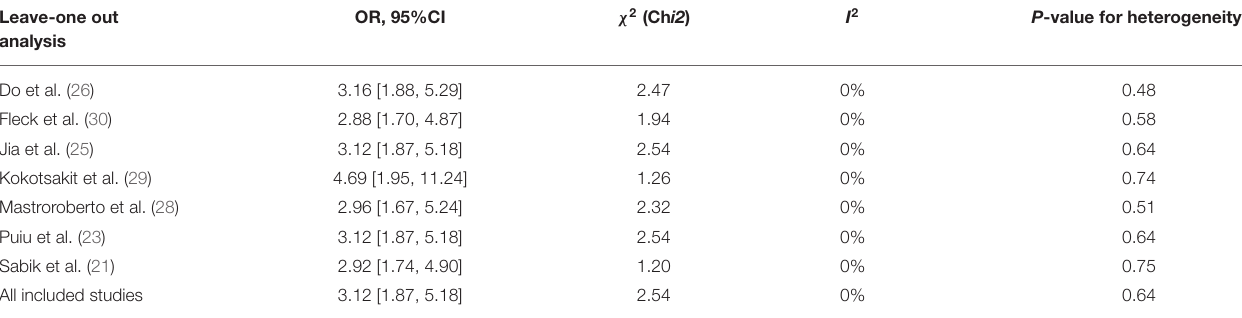
TABLE 5 | Sensitivity analysis with leave-one out analysis for cannulation